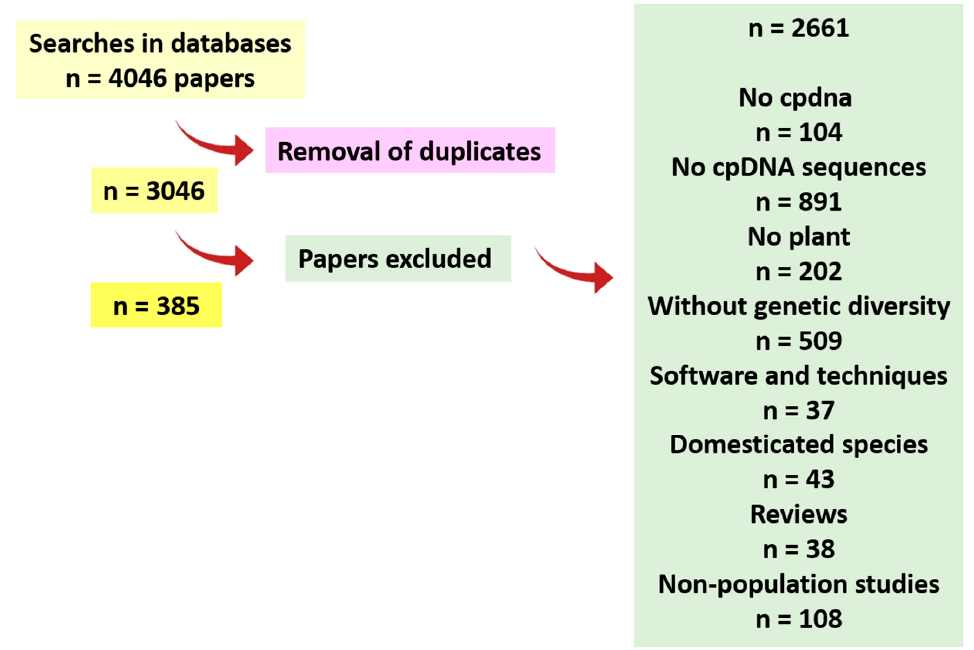
Figure 1. Diagram of the steps taken to refine the results of the searches and select the papers on plant genetic diversity based on chloroplast sequences analyzed in the present